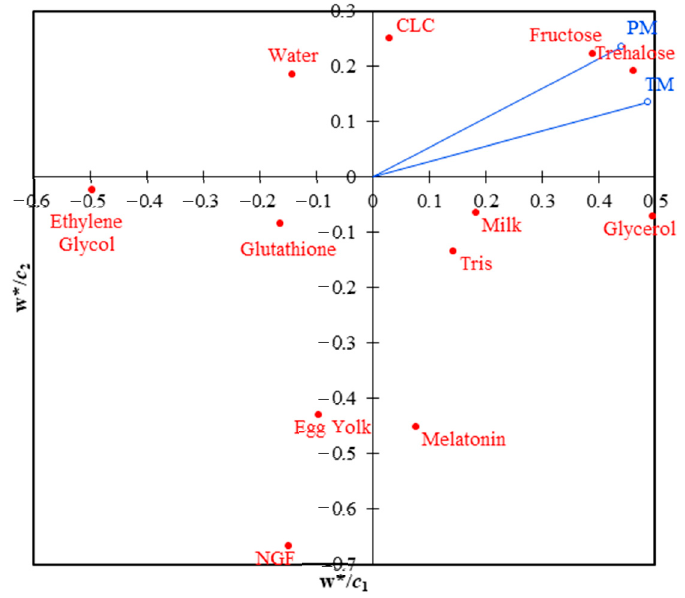
Figure 1. PLS variable loading plot for the two first components ( w */ c 1 and w */ c 2 ), explaining how the Y variables (TM: total motility and PM: progressive motility) correlate to the X variables and the correlation structure.